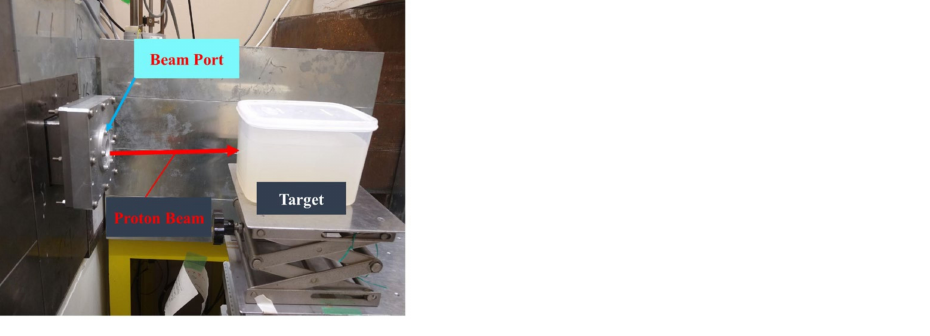
Figure 2. Experimental setup of proton irradiation of water-gel phantom using a pencil-like proton beam with an energy of 80 MeV.